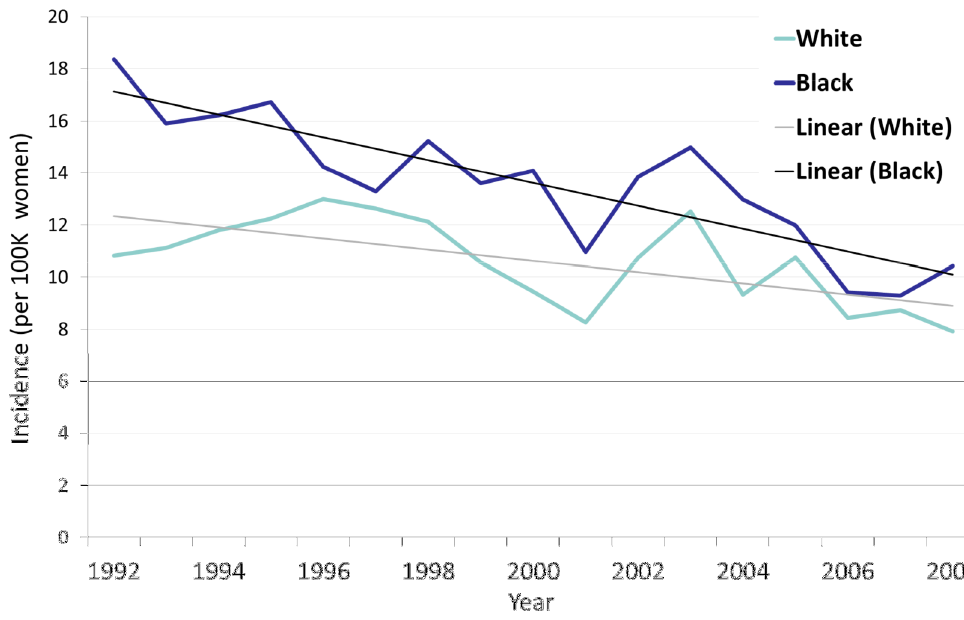
Figure 1. Annual incidence of cervical cancer in Maryland by race for women 20 and older, 1992–2008.